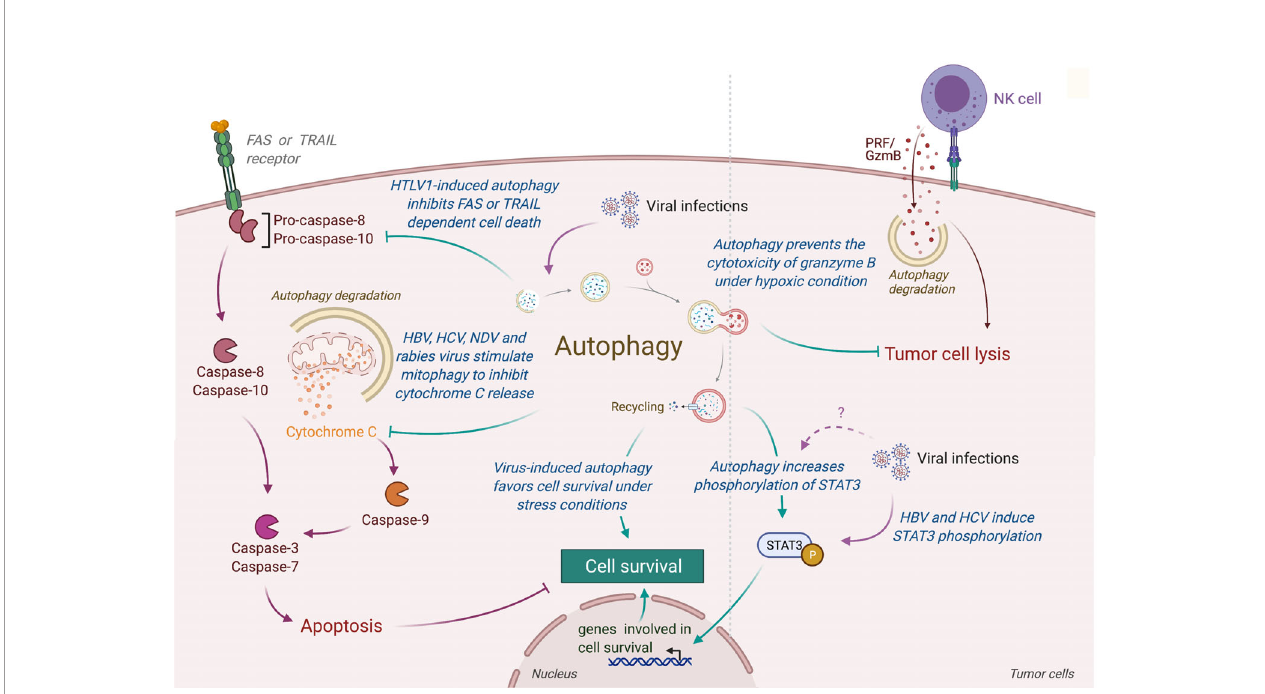
FIGURE 4 | Role of virus-induced autophagy in tumor cell survival. Viral infections can induce autophagy in tumor cells, leading to a protection of tumor cells from stress-induced or immune cells-induced cell death. In one hand, autophagy protects tumor infected cells from stress conditions (e.g., starvation or hypoxia) by limiting the accumulation of damaged organelles or by increasing the expression of genes involved in cell survival (e.g., via the phosphorylation of SATA3). In another hand, virus-induced autophagy limits the induction of apoptosis, protecting tumor cells from death receptor- or mitochondria-mediated cell death. Autophagy also takes part in the resistance of infected tumor cells from immune cell lysis by targeting and neutralizing granzyme B activity. HTLV-1, Human T cell Leukemia/lymphoma Virus type 1; HBV, Hepatitis B Virus; HCV, Hepatitis C Virus; NDV, Newcastle Disease Virus; PRF/GzmB, Perforin/Granzyme